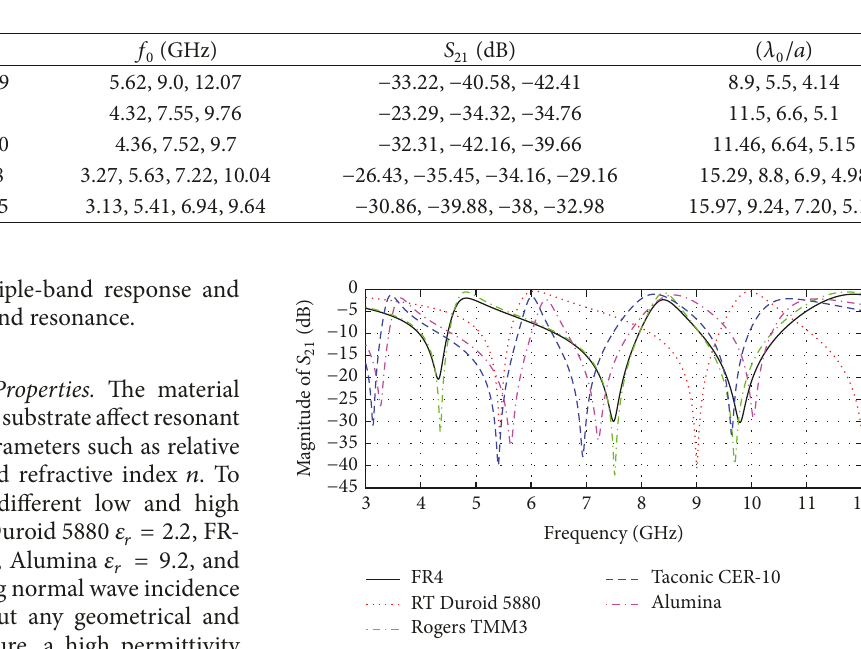
Figure 11: Effect of permittivity of the substrate on 𝑆 21 resonance.